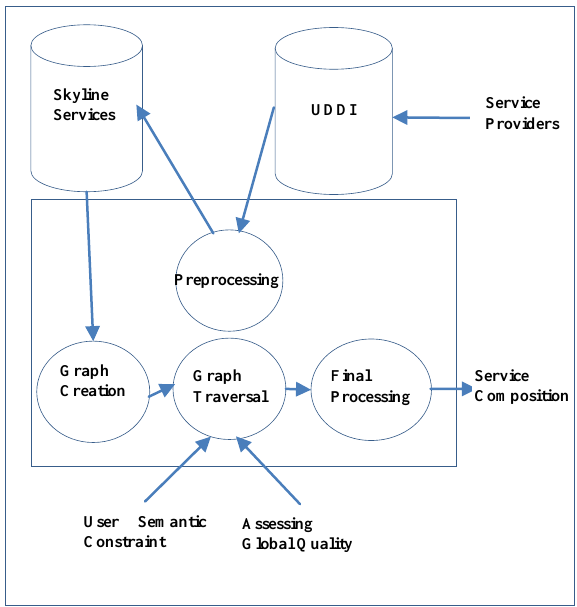
Figure 1. Block diagram of the proposed